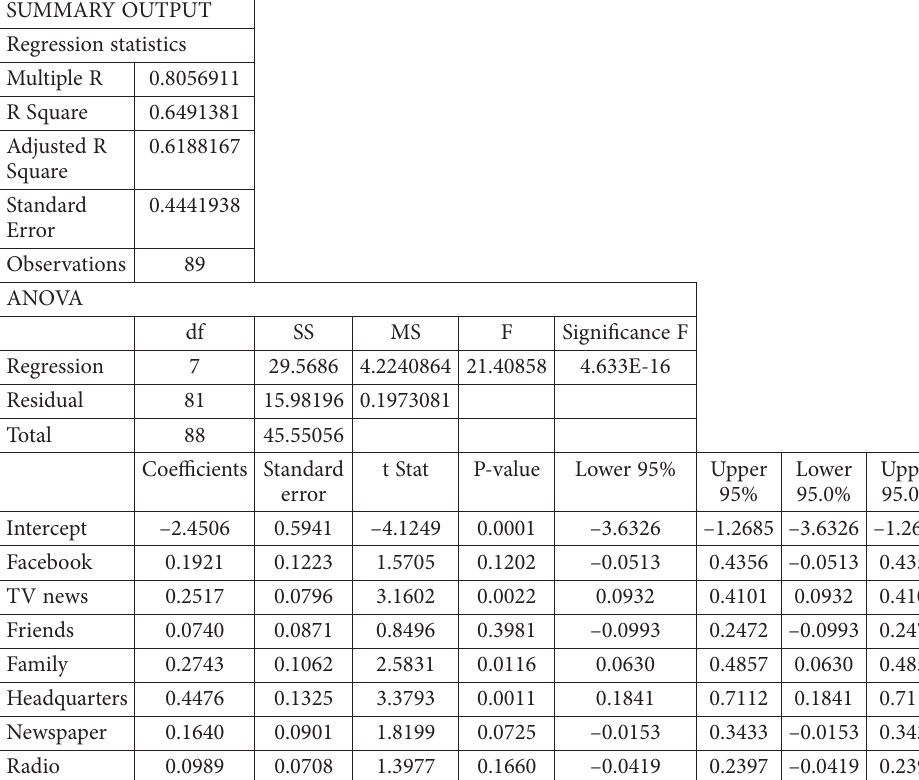
Table 4. Results of multi-variant regression (source: prepared by authors) SUMMARY